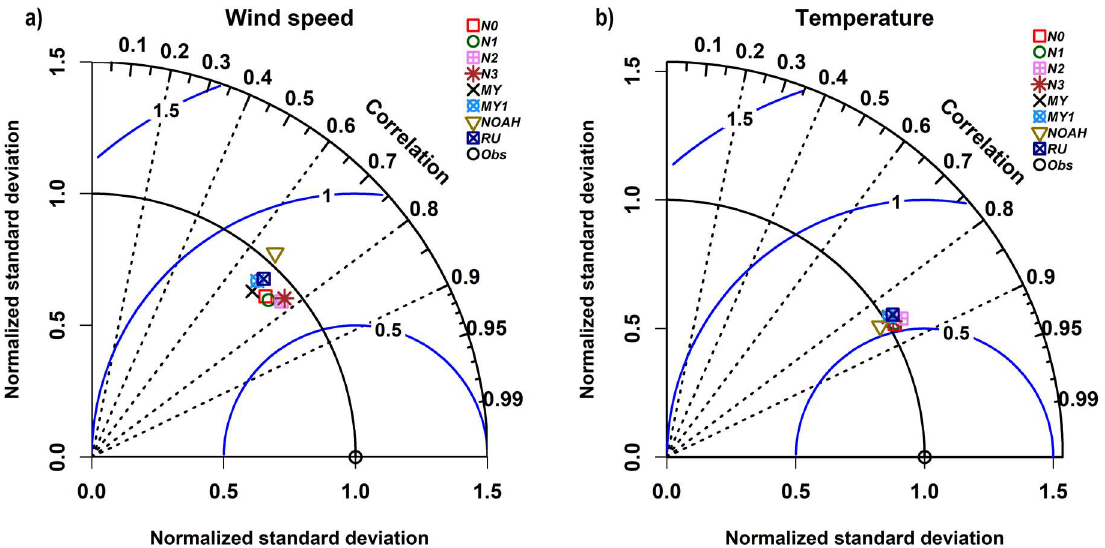
Figure 12. Taylor diagrams for ( a ) wind speed and ( b ) temperature for the whole dataset. The dashed line represents correlation, the radial distance (black line) from the origin represents the normalized standard deviation, and the semicircles (blue line) centered at the observed (Obs) marker represent the centered root mean square error.